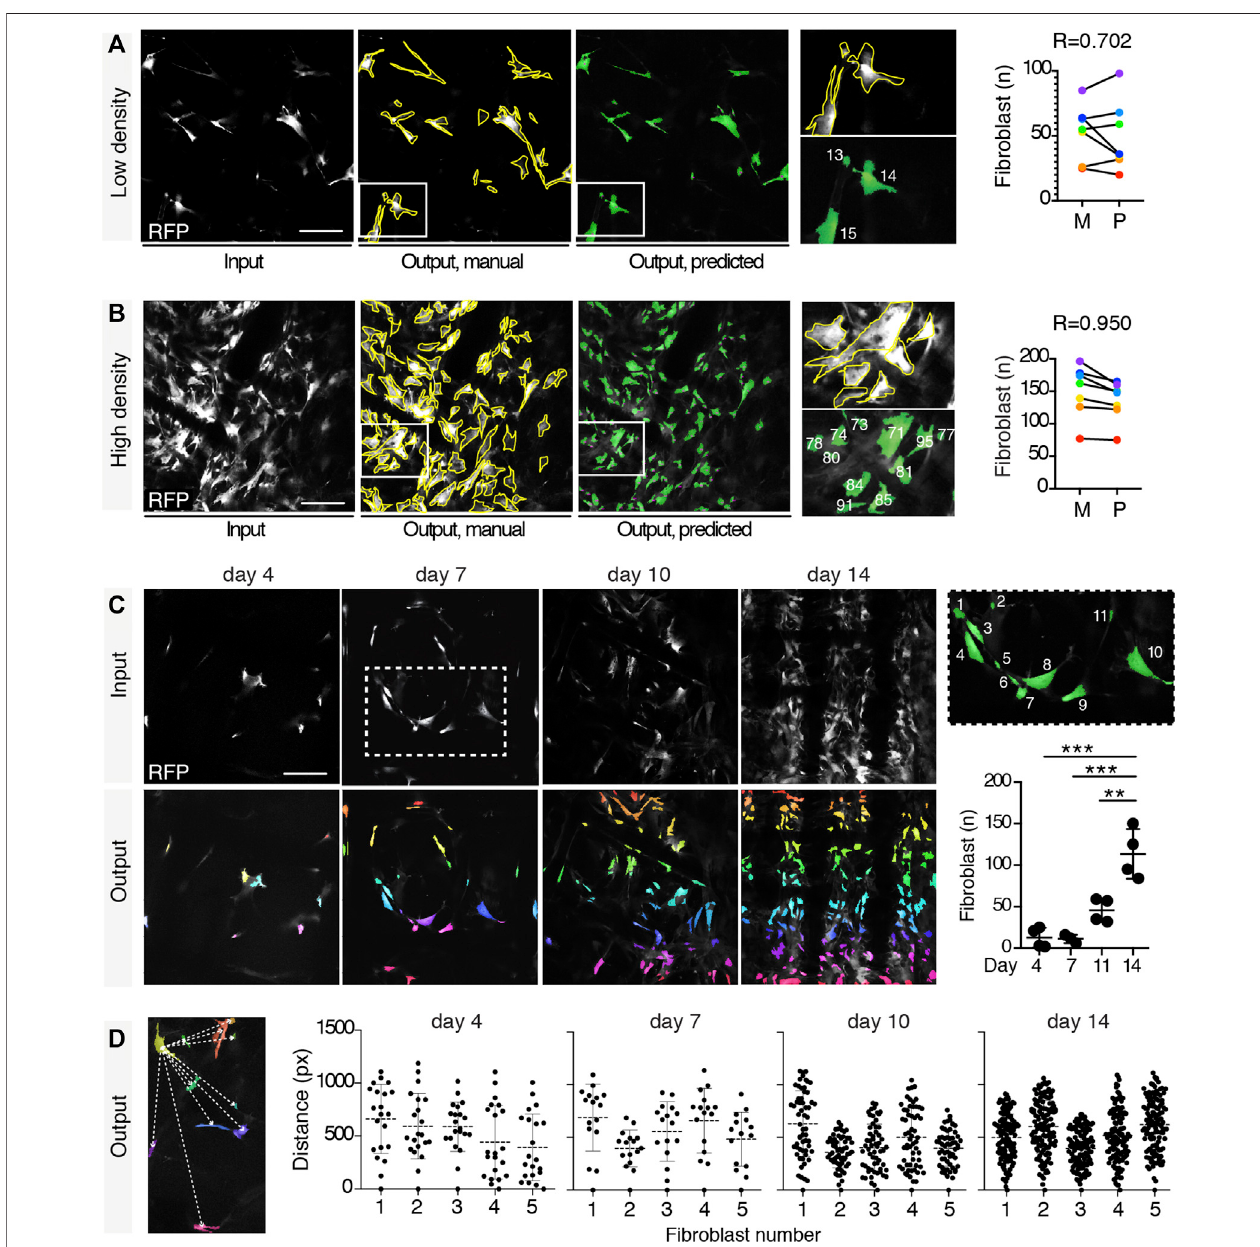
FIGURE 4 | Fibroblast segmentation and extraction of parameters. Segmentation of fi broblasts in a low- (A) and a high-density (B) setting. Input images in gray, target manual labels with yellow outlines, and predicted segmentation masks in green. Magni fi cations of fi broblasts manually segmented, and their relative predicted output are shown (each different fi broblast is numbered in white). Pearson correlation between the number of fi broblasts in low- and high-density settings according to the manual and the predicted outputs (obtained from 7 independent images) is shown. (C) Automatic quanti fi cation of the number of fi broblasts at days 4, 7, 11, and 14 post-implantation. Representative input images for each time point (gray) with relative predicted outputs (rainbow color map). Right panel shows a magni fi cation (inset, day 7)ofthepredicted output(each fi broblast isnumbered inwhite).Rightgraphshows thequanti fi cation ofthenumberof fi broblasts at each timepoint obtained by automatic count ( n (cid:1) 4 mice, three images/mouse). * p < 0.05, ** p < 0.01, *** p < 0.001 (unpaired two-tailed Student ’ s t -test). Scale bar, 100 μ m. (D) Extraction of mutual distances between centroids. Left panel shows a representation ofthe distance(white dashed lines) between thecentroid ofthe yellow-colored fi broblastand all the other fi broblasts. Graphs show the distribution of the mutual distances between centroids at days 4, 7, 11, and 14 post-implantation ( n (cid:1) 5 regions in 3 mice).